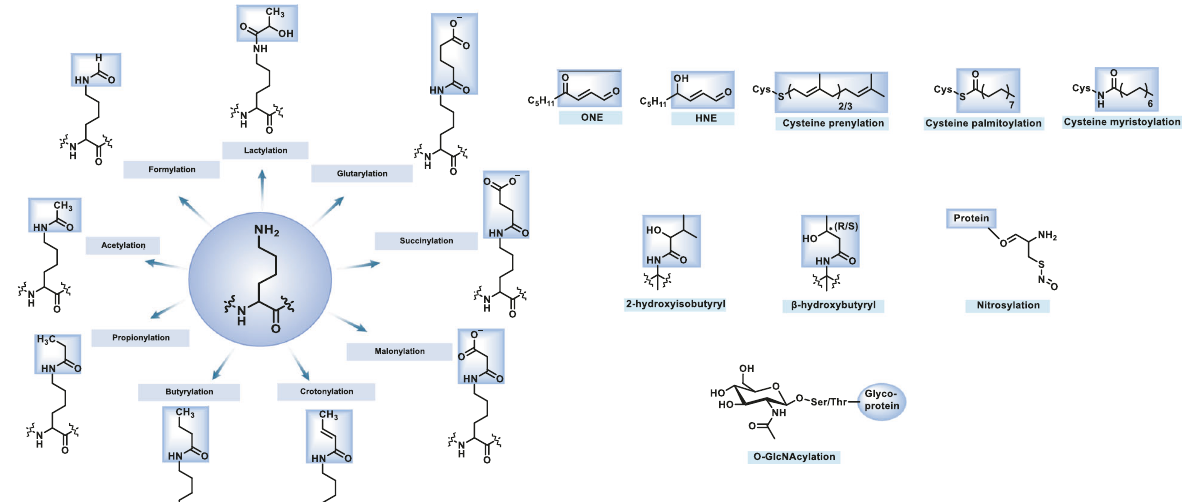
Fig. 1 Chemical structures of histone/non-histone PTMs in this